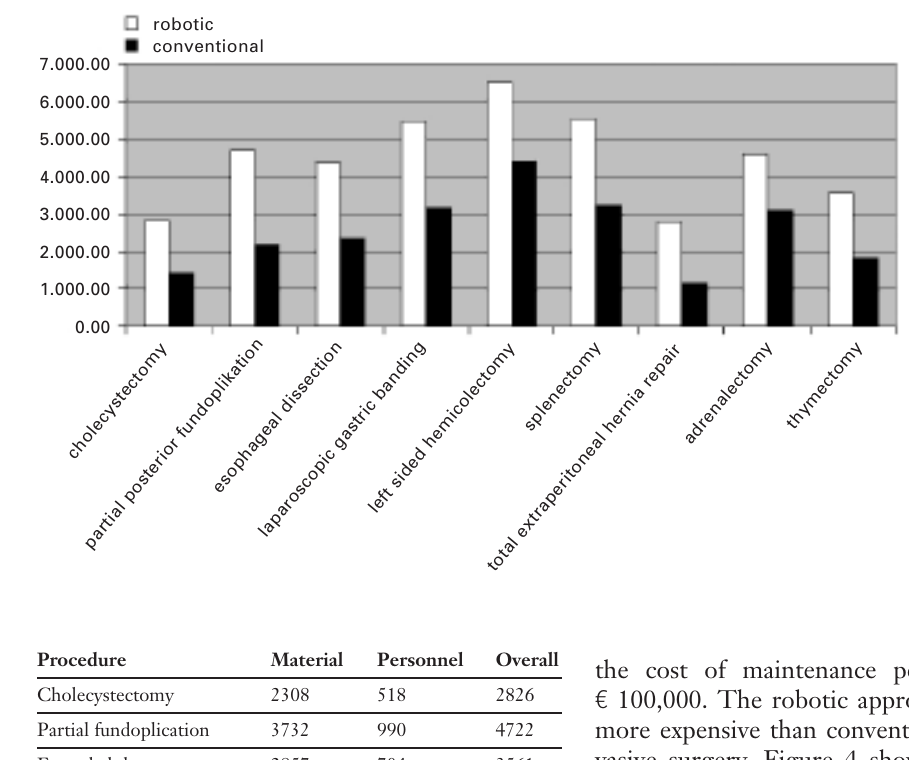
Procedural costs (median per patient, in H ): robotic versus conventional mini- mally invasive sur- gery.